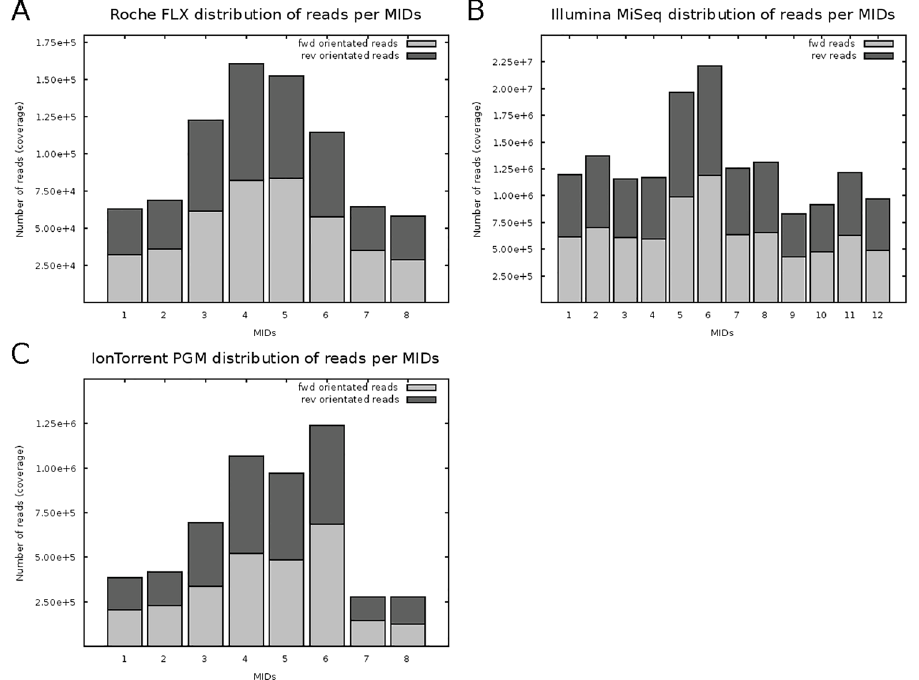
Fig 2. Platform comparison — read distribution. Total number of reads (coverage) for each single barcoded amplicon library generated by 454 (A), Illumina (B), and IonTorrent (C) platform are shown in both forward (light grey) and reverse (dark grey) read